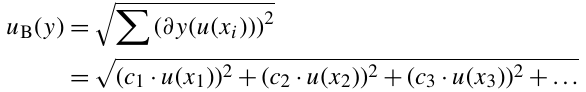
Figure 5. Phase displacement of a class 0,2S current transformer (Mohns,